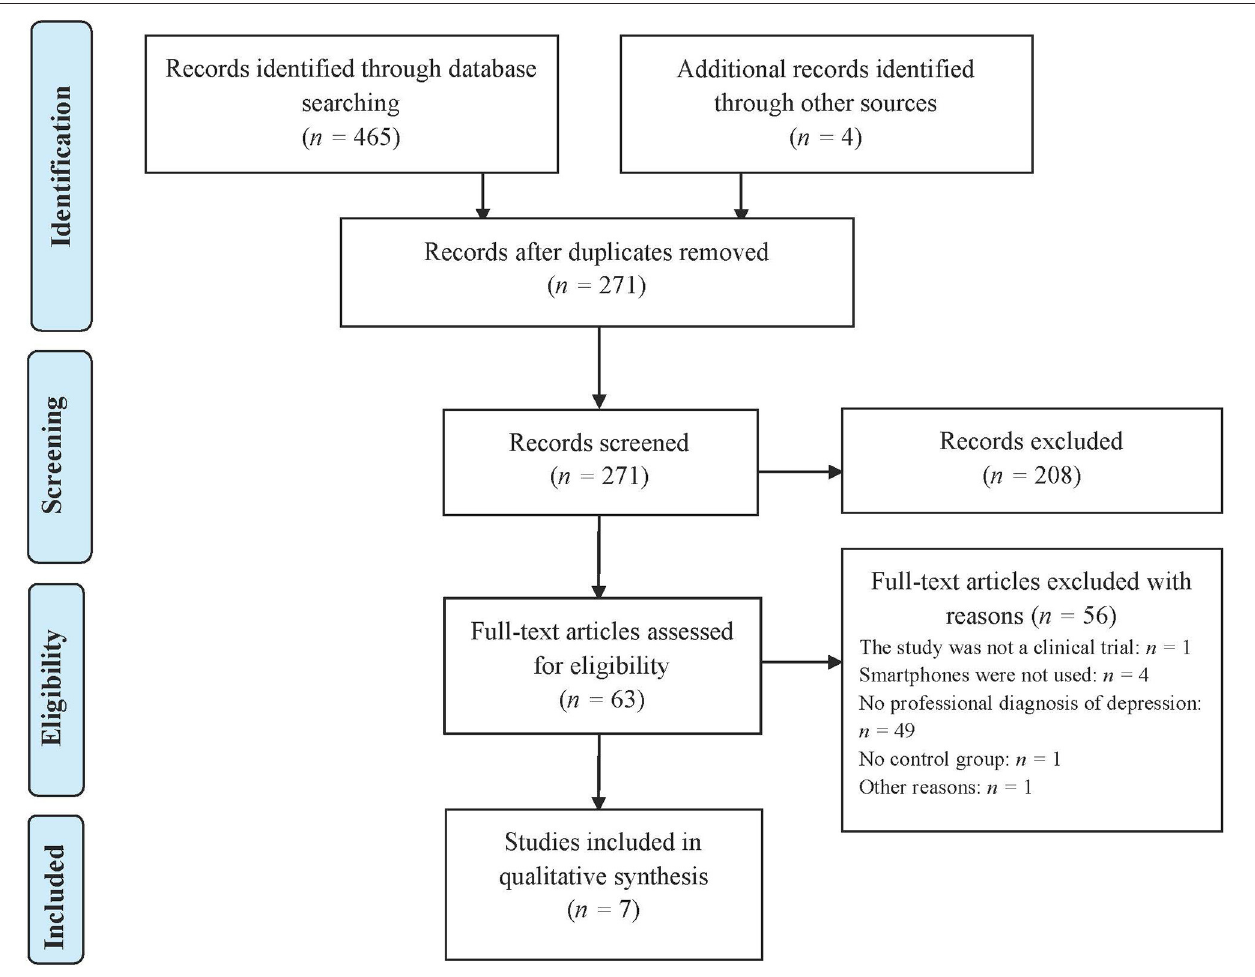
FIGURE 1 | PRISMA flow diagram of the article selection